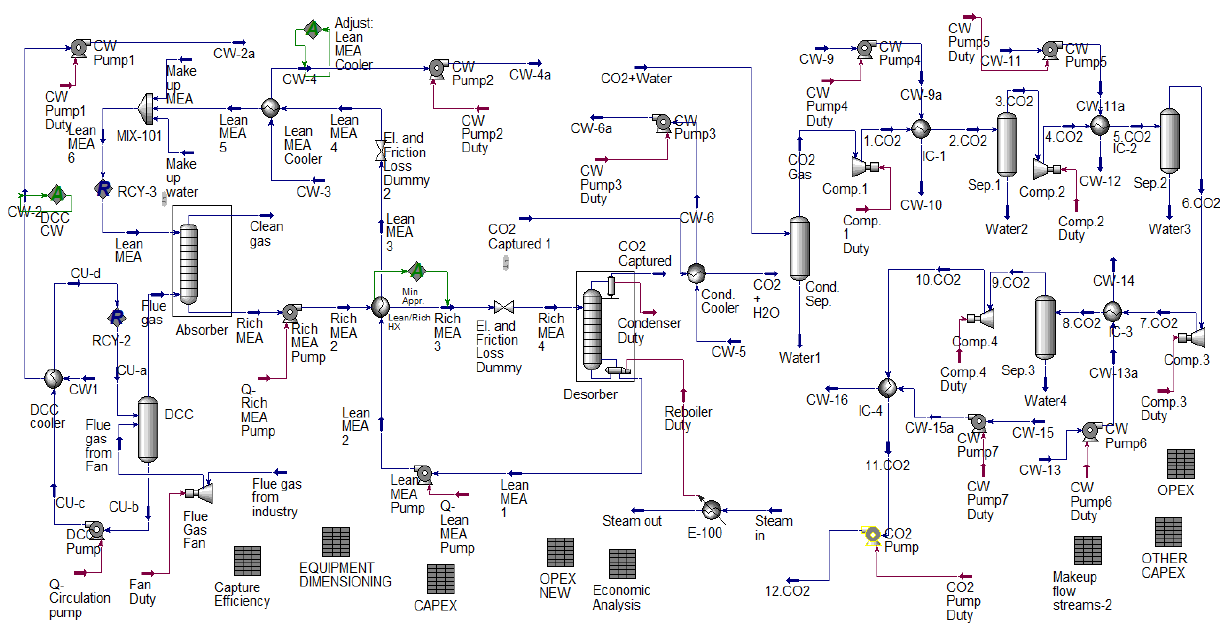
Figure A1. Aspen HYSYS simulations process flow diagram of the NGCC power plant standard CO 2 capture process.